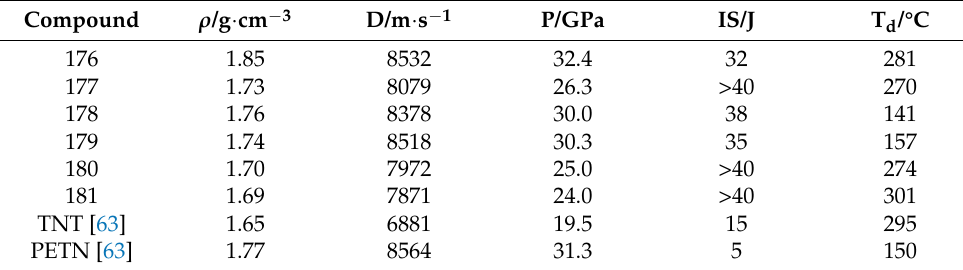
Table 3. Physical and detonation properties of compounds 177–181